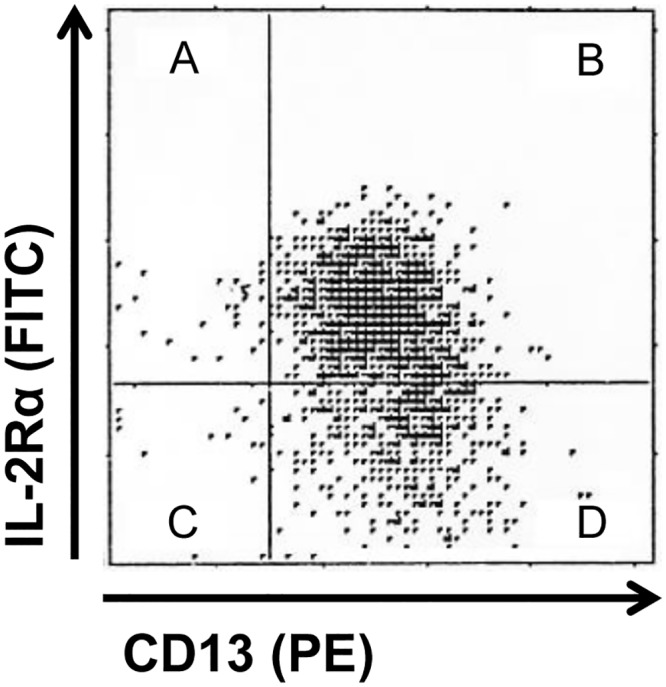
Double immunostaining of leukemia cells using anti-IL-2Rα and anti-CD13 antibodies in a representative patient with IL-2Rα+CD4+AML.The horizontal axis indicates the logarithmic scale of FITC-conjugated anti- IL-2Rα binding, and the vertical axis PE-conjugated anti-CD13 binding. IL-2Rα and CD13 dual-positive cells are shown in the right upper quadrant (B).